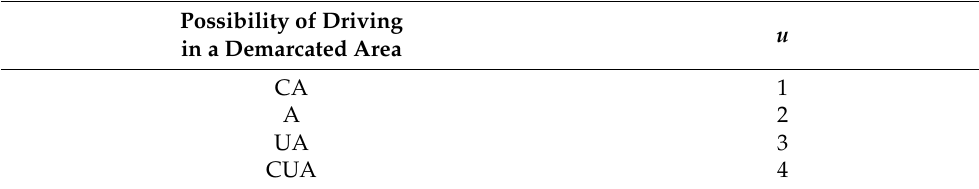
Table 3. Weight according to free space